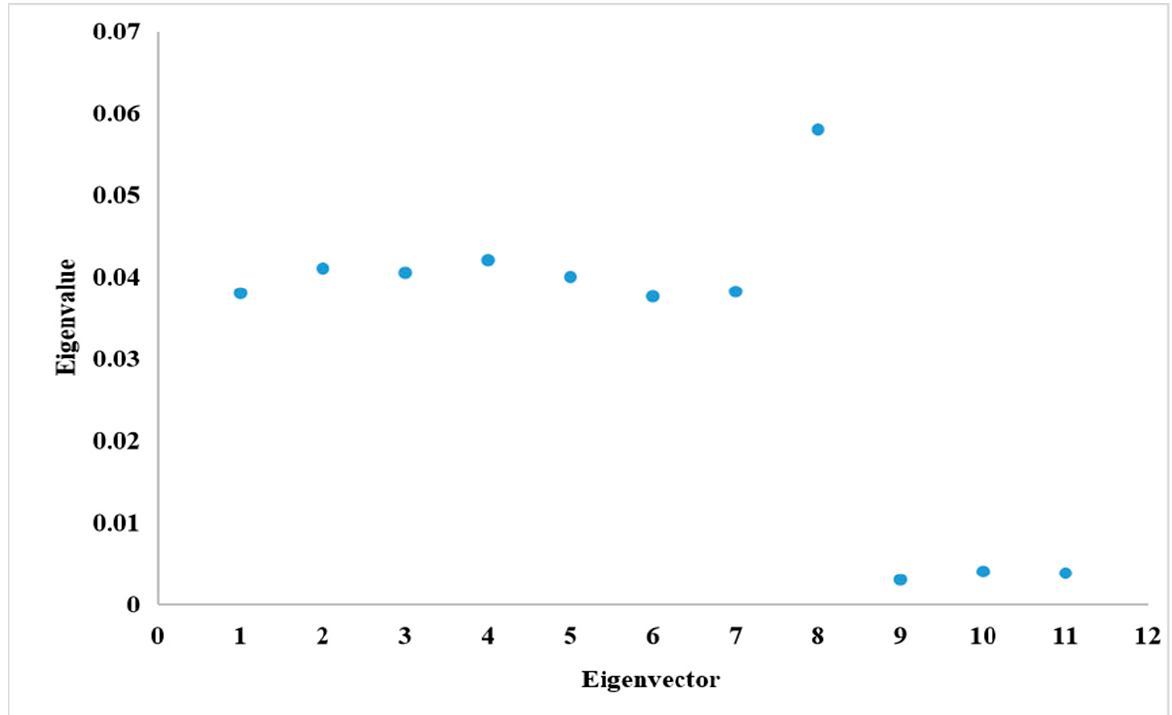
Figure 3. The optimal number of clusters corresponding to the eigenvectors of the Laplacian operator in all samples. The horizontal axis represents the eigenvectors, and the vertical axis represents the eigenvalues.